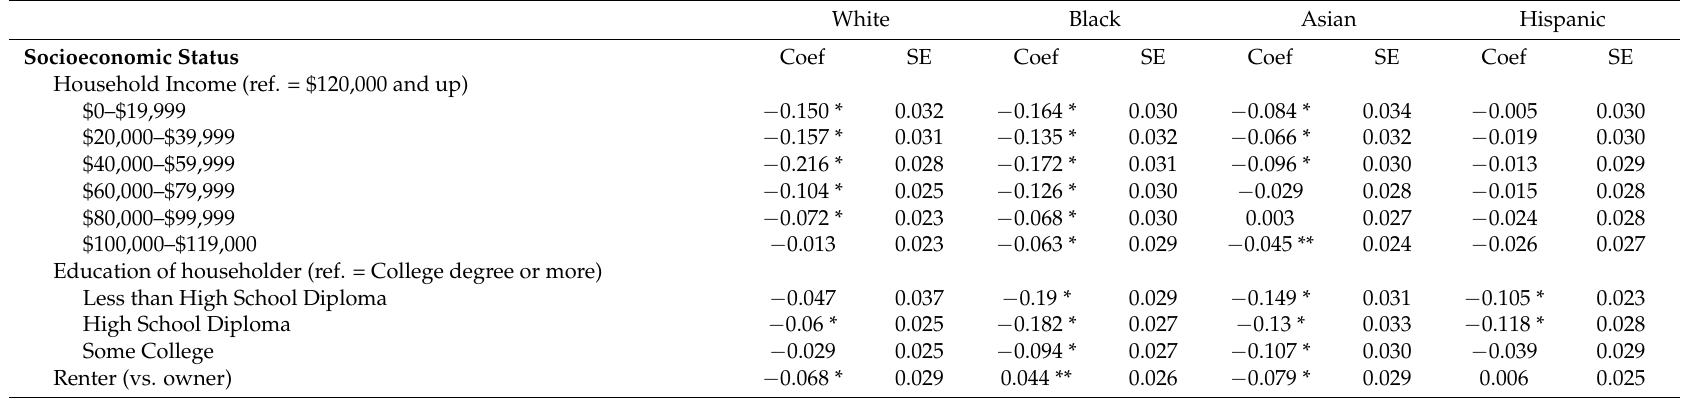
Table A2. Group Specific Logisitic Regression Results Predicting Developing (vs. Mature) Suburban Outcomes-Standardized Coefficients (Standard